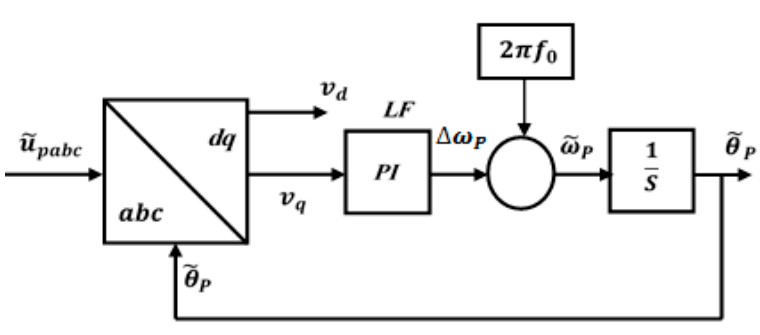
Figure 4. SRF-PLL model [3].